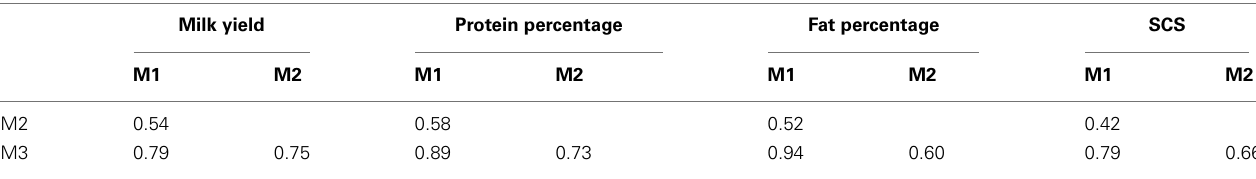
Table 3 | Spearman correlation coefficients between proportions of variance explained by chromosomes across the three estimation methods for the four traits.